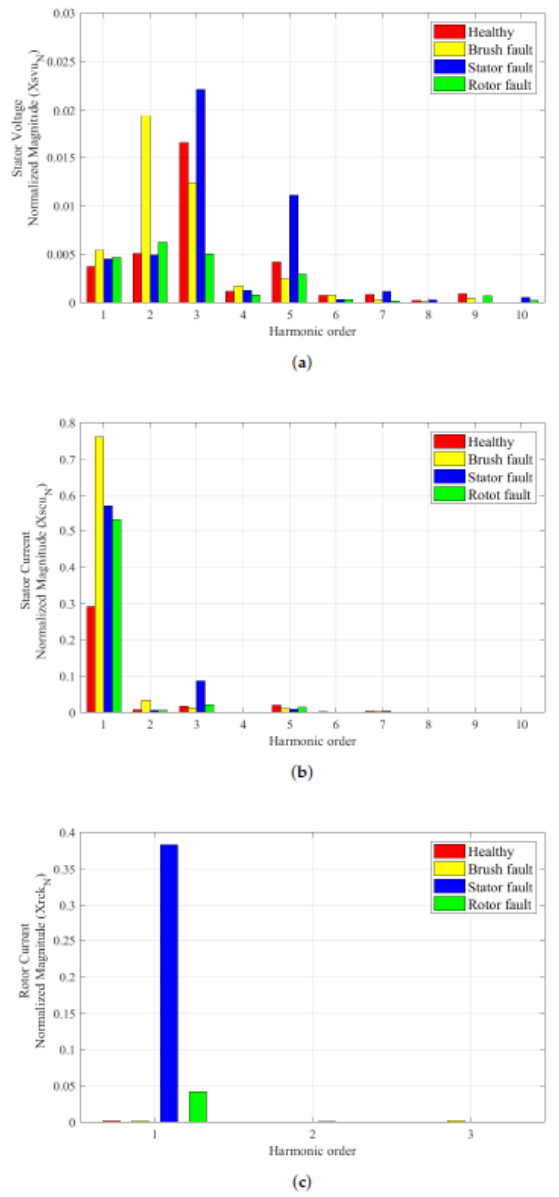
Figure 5. Experimental frequency spectra (excluding the fundamental due to normalization) for one phase of, ( a ) stator voltage, ( b ) stator current, and ( c ) rotor current, under health and different